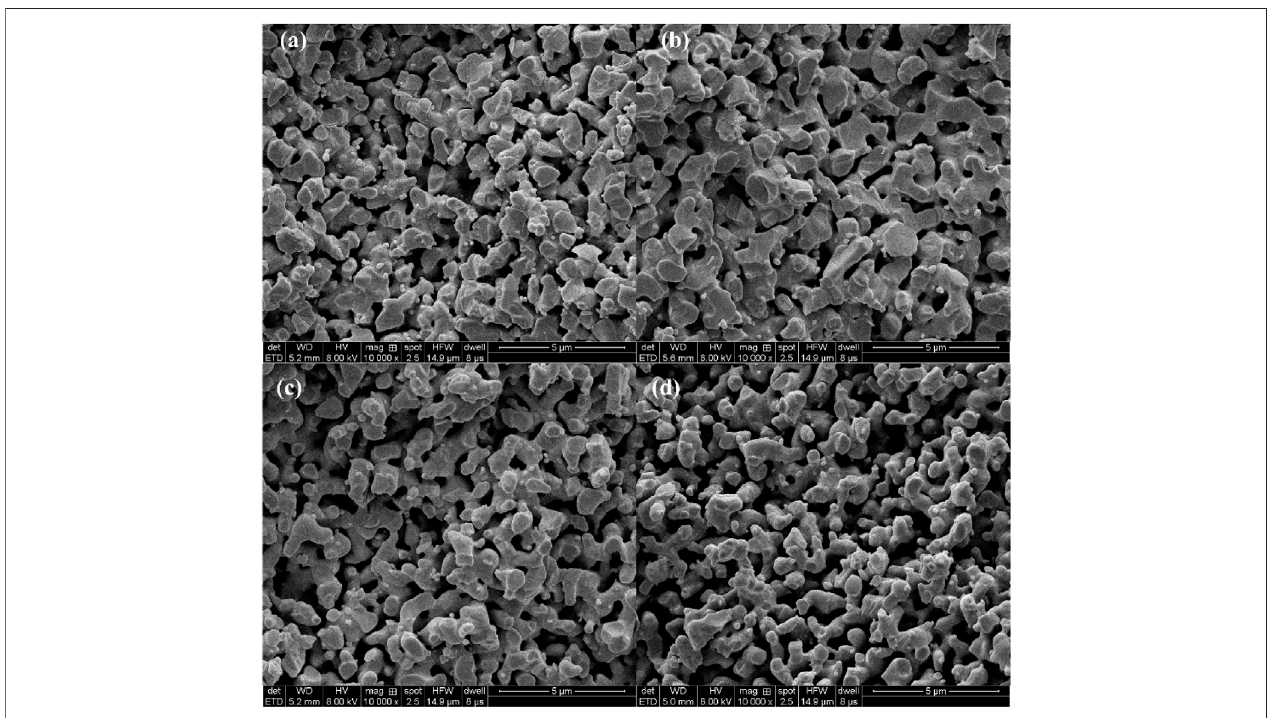
FIGURE 4 | SEM image of the samples obtained at 1333 K with different carbon black contents of 0wt% (A) 1.5wt%, (B) 5wt%, and (C) 10wt% (D) .